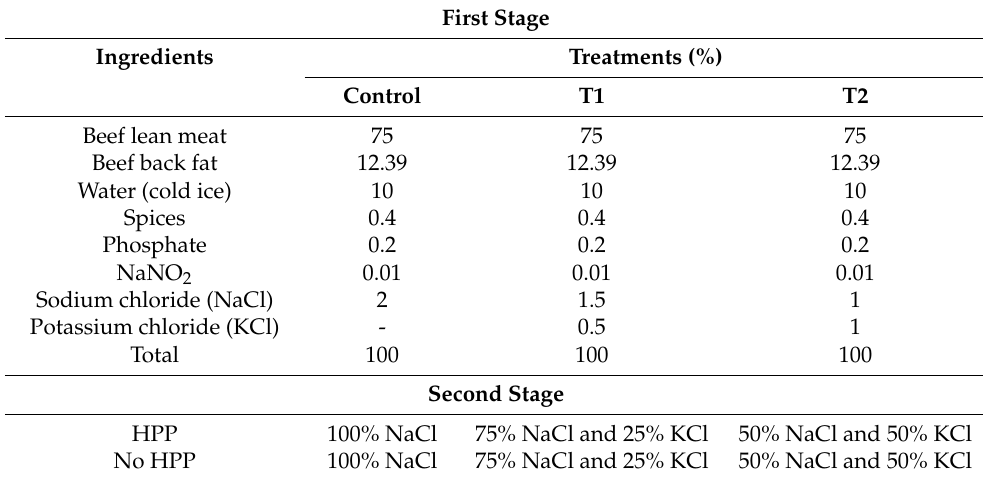
Table 1. Percentages of sodium chloride and potassium chloride used in the formulation of beef sausage.